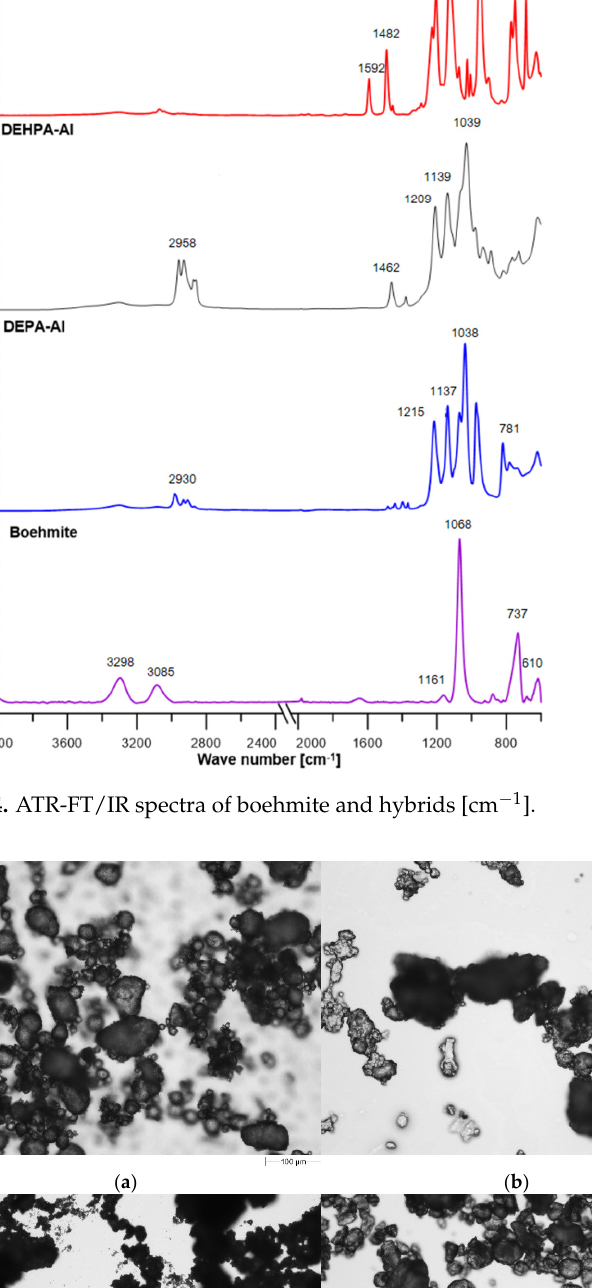
Table 4. TG data for hybrids in helium.